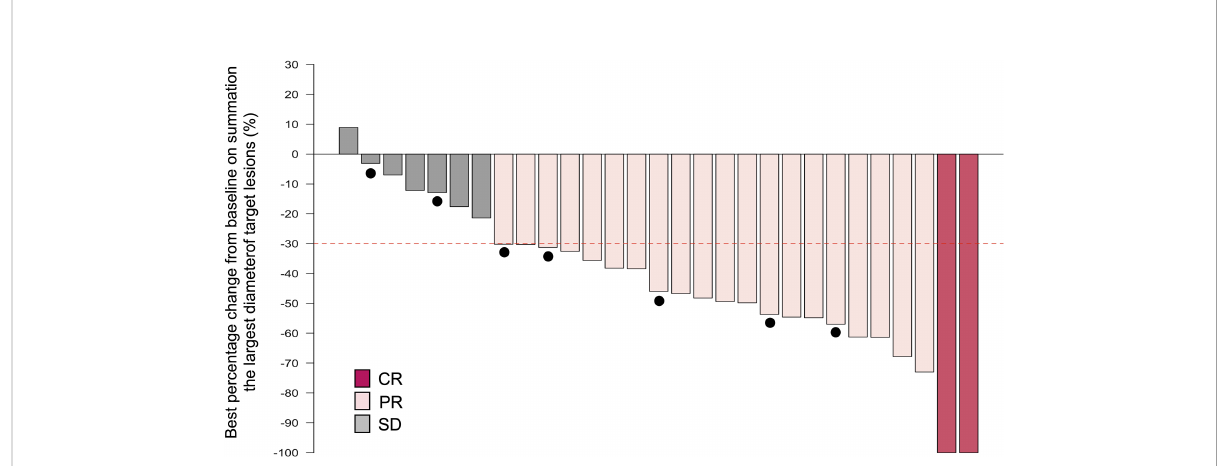
FIGURE 2 Waterfall plot of the maximum percentage change from baseline on summation of the largest diameter of target lesions by induction chemotherapy. Note that the dashed line indicates a 30% reduction in tumor burden in the target lesion and closed circles indicate cases with late recurrence. CI, con fi dence interval; CR, complete response; PR, partial response; SD, stable disease; PD, progressive disease.